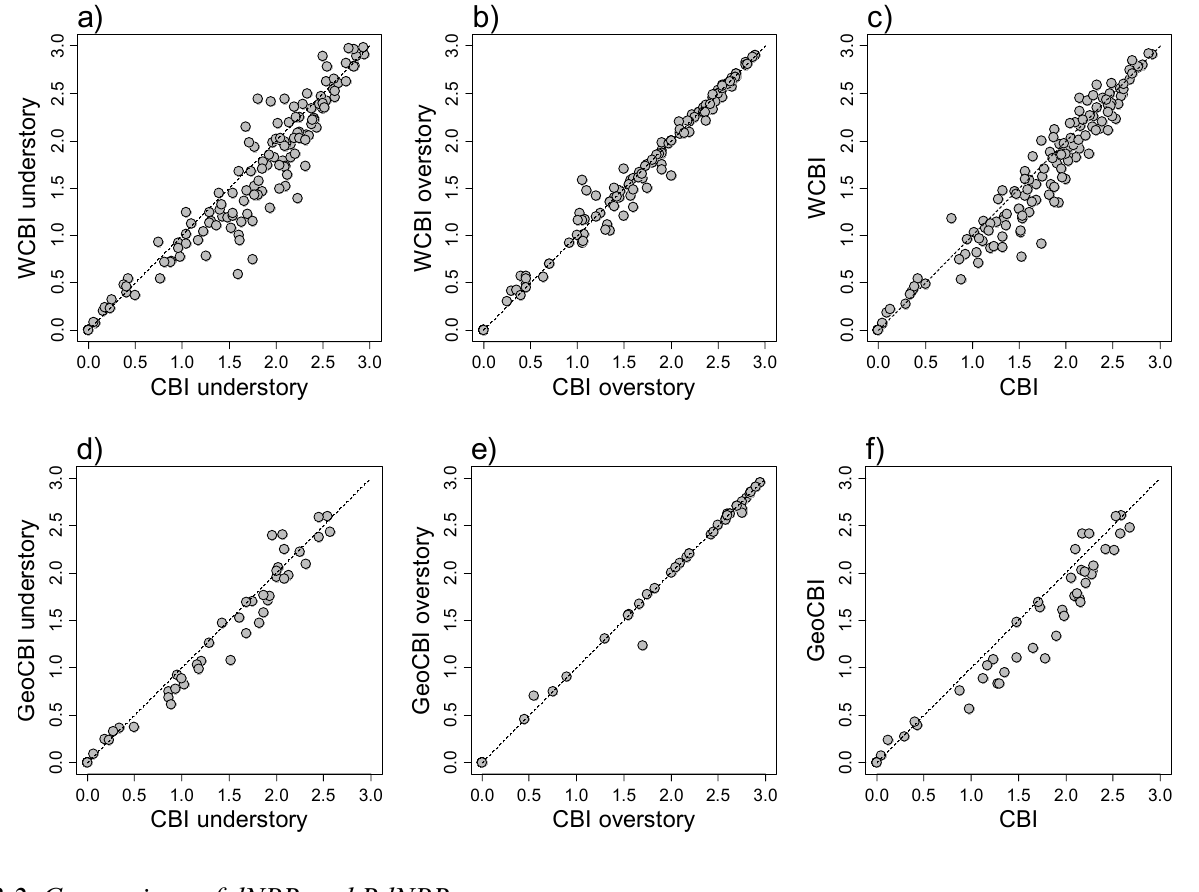
Figure 4. Top: CBI and WCBI for ( a ) understory strata (substrates, herbs and low shrubs, tall shrubs), ( b ) overstory strata (intermediate trees, and dominant trees), and ( c ) the plot. Bottom: CBI and GeoCBI for ( d ) understory strata (substrates, herbs and low shrubs, tall shrubs), ( e ) overstory strata (intermediate trees, and dominant trees), and ( f ) the plot. Dashed lines shows theoretical CBI = WCBI, or CBI =